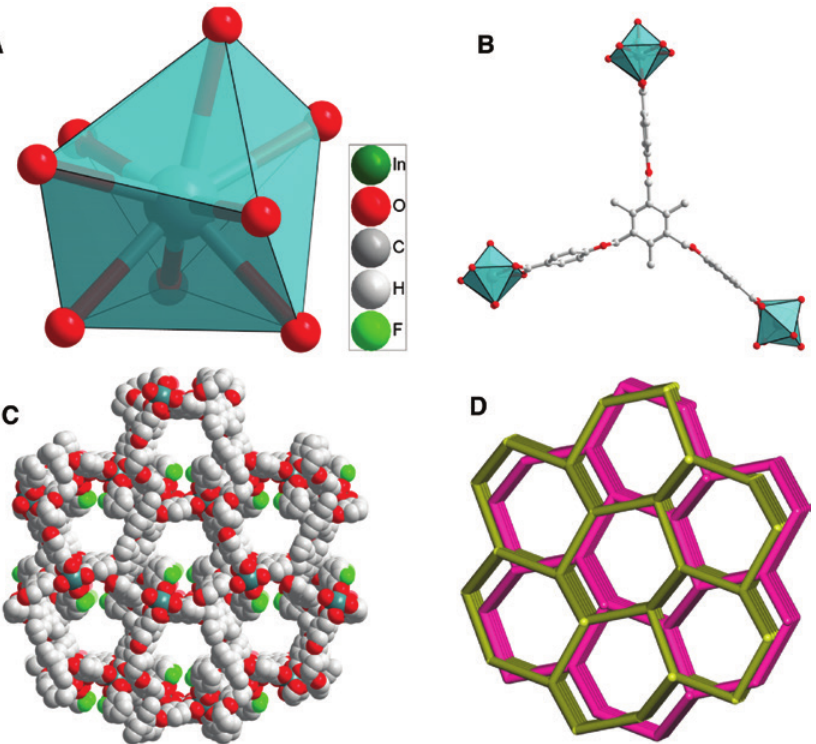
Figure 3: (A) Picture showing the coordination mode of In(III) ion in 2 . (B) Views of the coordinating mode of the ligand. (C) View of the 3D framework of 2 . (D) View of the simplified network of 2